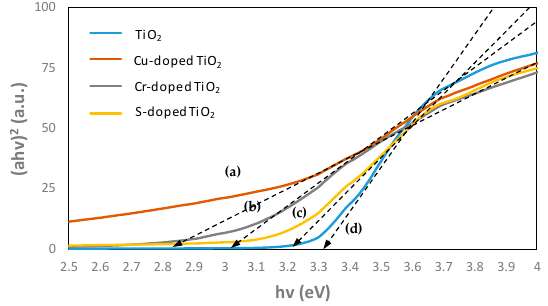
Figure 14. Determination of energy band gap E g for TiO 2 specimens: ( a ) Cu-doped TiO 2 ; ( b ) Cr-doped TiO 2 ; ( c ) S-doped TiO 2 ; ( d ) TiO 2 .